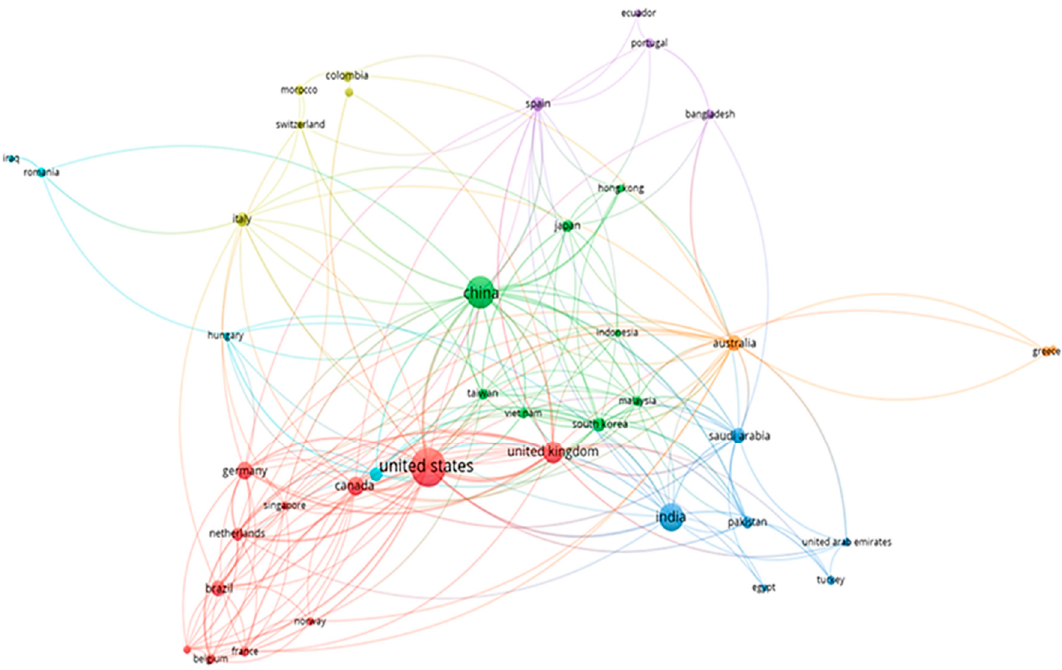
Figure 6. Correlations of ML and secision ‐ making processes, Scopus database.